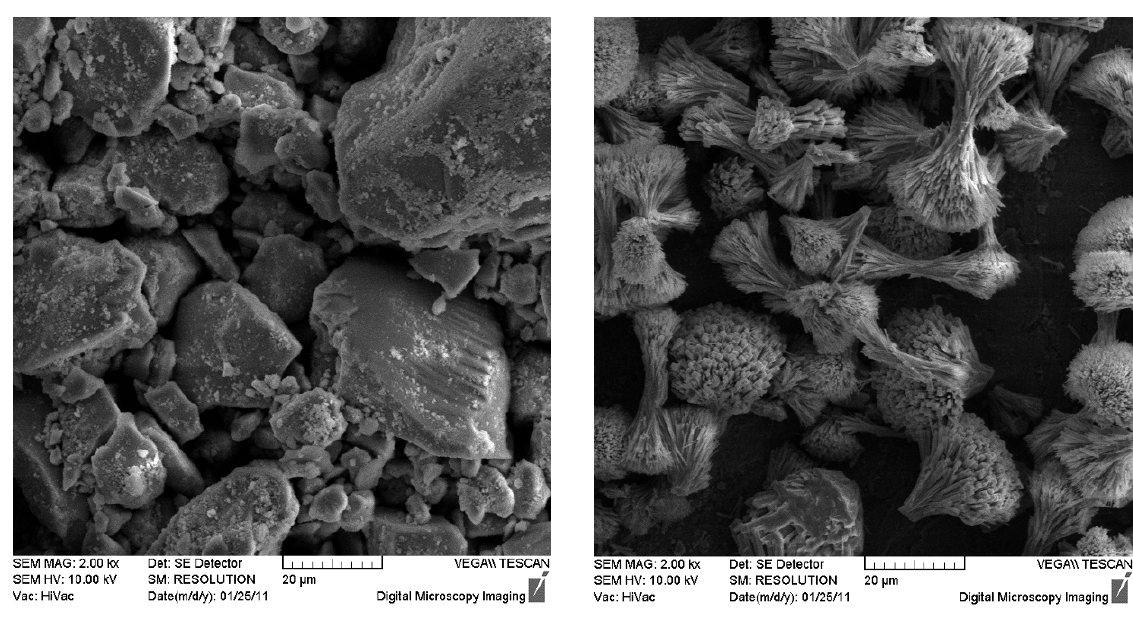
Figure 5. SEM image of a sample that was hydrothermally treated for 25